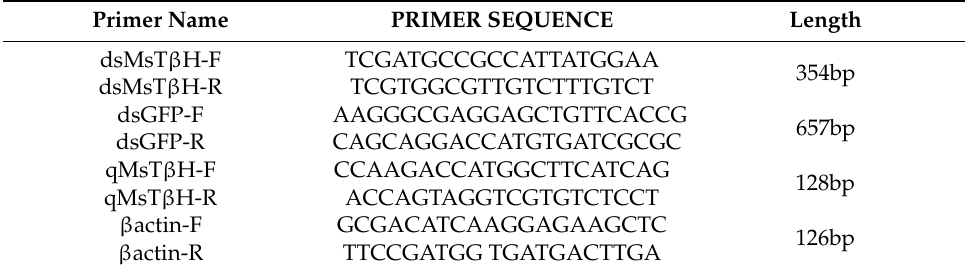
Table 1. Sequence of primers used for double strand RNA (dsRNA) synthesis and quantitative PCR (qPCR) of RNAi in M. separata tyramine β -hydroxylase